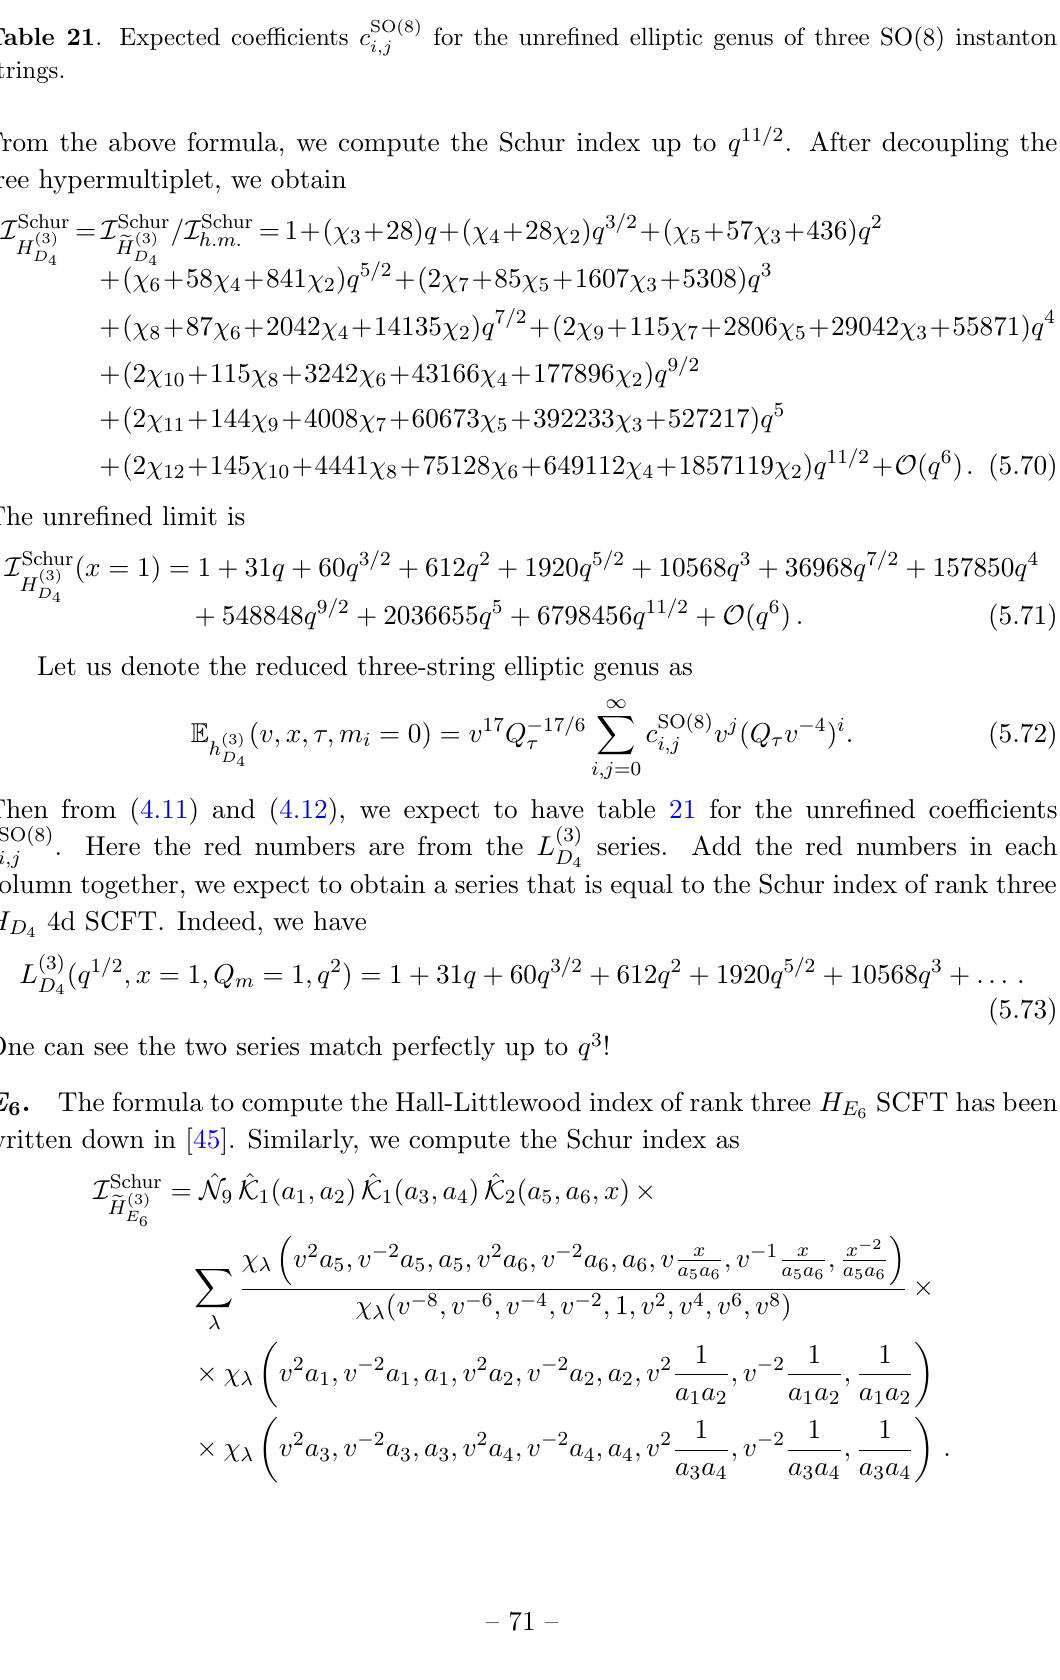
Table 21 . Expected coe(cid:14)cients c SO(8)